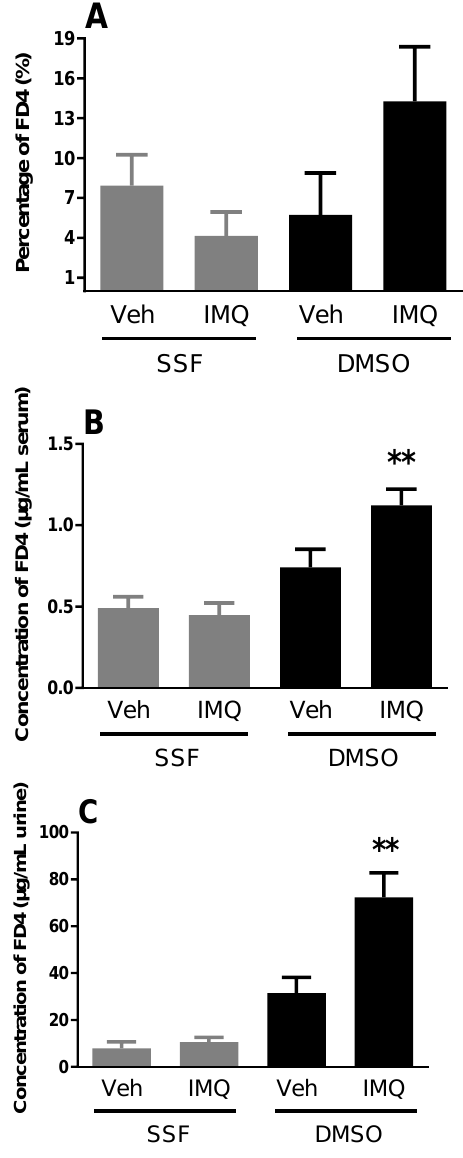
Figure 3. Effects of imiquimod (IMQ) on colonic permeability to FD4 in in vivo conditions. Data show the accumulation of FD4 on the colonic wall ( A ) and the passage of FD4 from colon to blood (µg of FD4/mL serum, ( B )) and urine (µg of FD4/mL urine, ( C )) during a 30-min period in control conditions and after treatment with imiquimod with or without DMSO. Data are mean ± SEM, n = 9–11 animals per group. **: p < 0.01 vs. other groups (ANOVA). Veh: Vehicle. SSF: Saline. DMSO: Dimethyl sulfoxide.